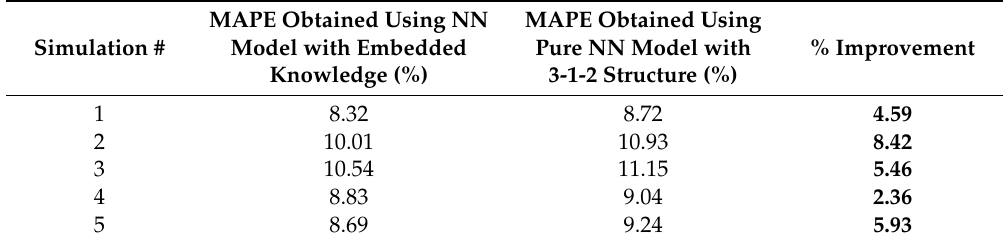
Table 1. Comparison of the MAPE obtained for the test set using the pure NN model with a 3-1-2 structure and the NN model with embedded knowledge.